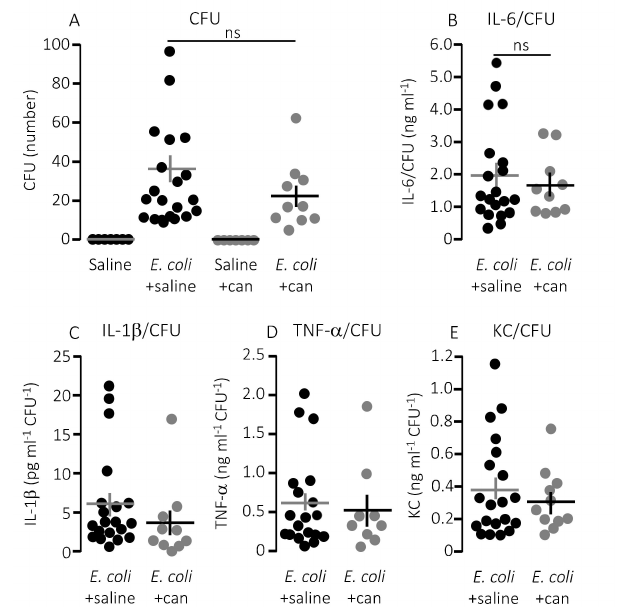
Figure 6. P2Y 12 receptor antagonist cangrelor (can) does significantly reduce keratinocyte chemoattractant (KC) in mice exposed to E. coli iv. The level of the following proinflammatory cytokines were measured in plasma from mice exposed to saline or cangrelor infusion (8.6 µ g / h) in the absence or presence of 30 × 10 6 E. coli iv: ( A ) TNF- α ; ( B ) KC; ( C ) IL-1 β ; and ( D ) IL-6. The data are given as single observations and mean ± S.E.M (saline n = 7, E. coli + saline n = 20, saline + cangrelor n = 7, E. coli + cangrelor (8.6 µ g / h) n = 10), * p < 0.05.